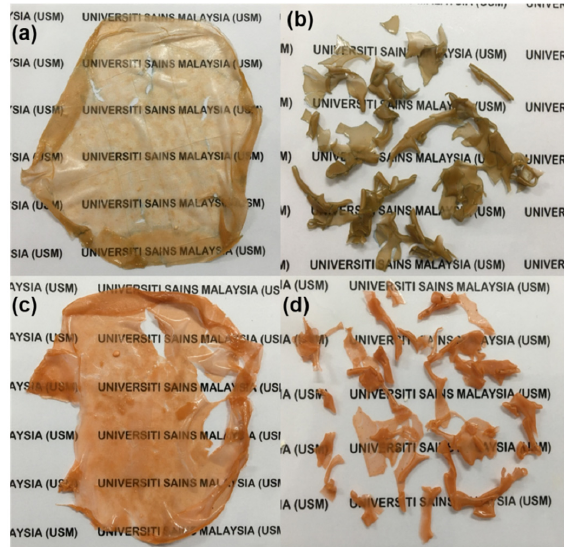
Figure 10. The stability of the film of CMC/BFO and CCMC/BFO films after 3 ‐ h treatment for 10 ppm of Congo red ( a , b ) and methyl orange ( c , d ).